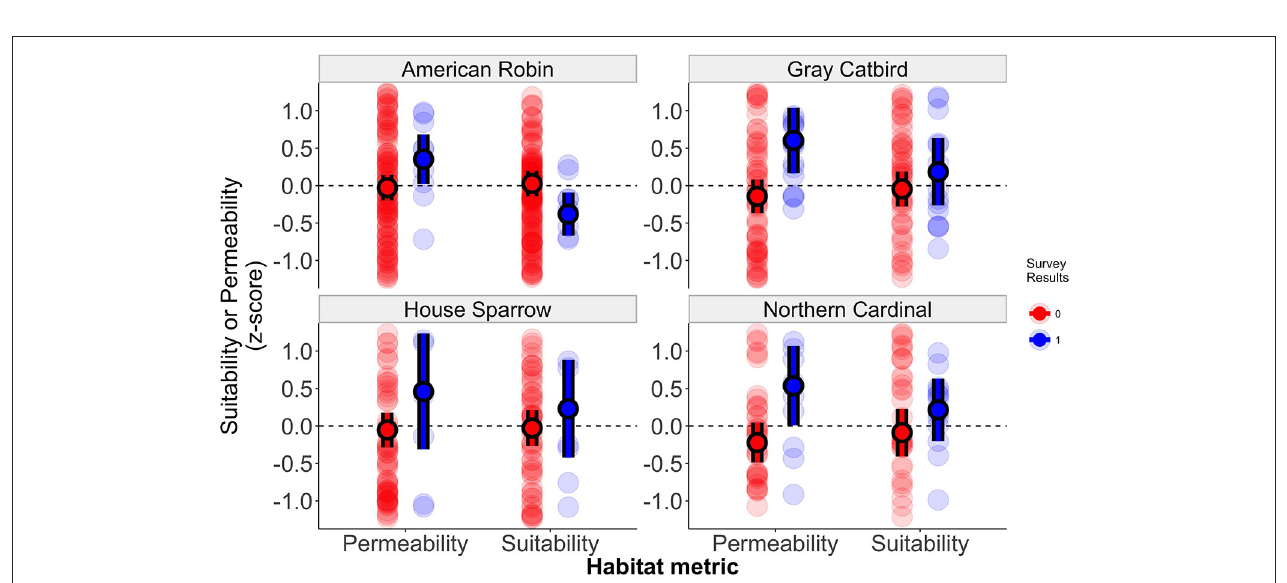
FIGURE 3 | Habitat connectivity and suitability of sites in which birds were resighted or in which no banded birds were observed. Standardized effect sizes represent habitat connectivity and suitability values for each banding station, with values above zero representing samples with high suitability or connectivity. Solid points represent mean values for each category with error bars representing 95% confidence intervals about the mean. Semi-transparent points represent the observed